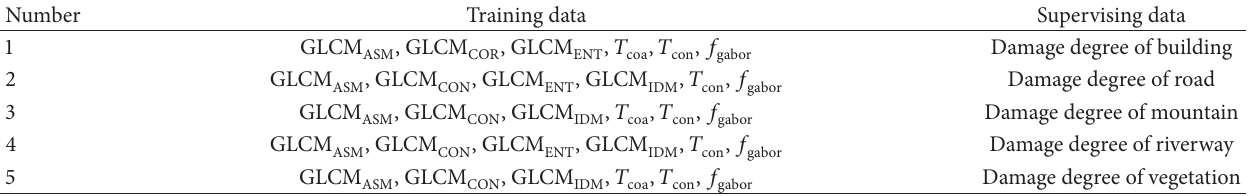
Table 1: The training data organization method of